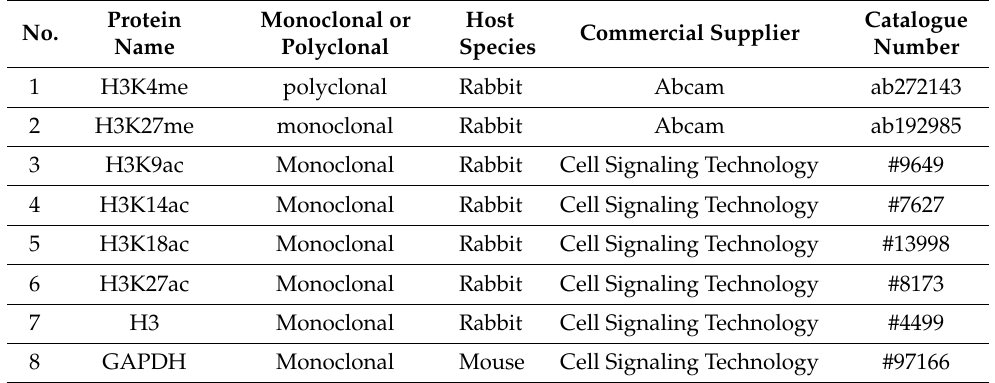
Table 1. Antibody and